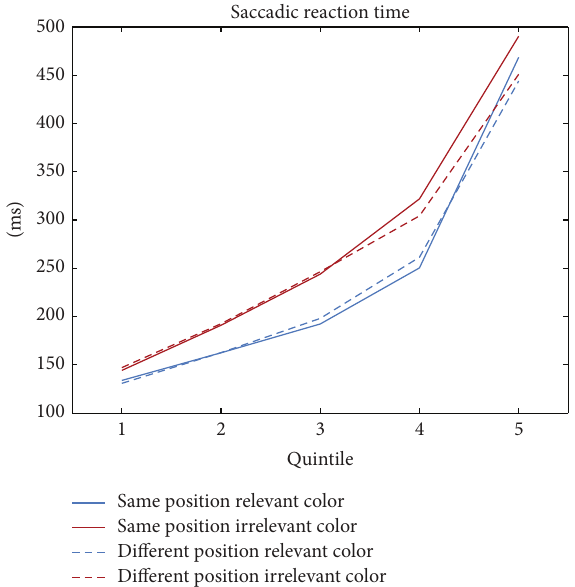
Figure 2: Saccadic reaction time (SRT) in milliseconds as a function of the first cue’s relevance (relevant cue = blue lines, irrelevant cue = red lines), cue position (at the same position as the target = solid lines, at a different position than the target = dashed lines), and the quintile of the SRT distribution (1 to 5, from fastest to